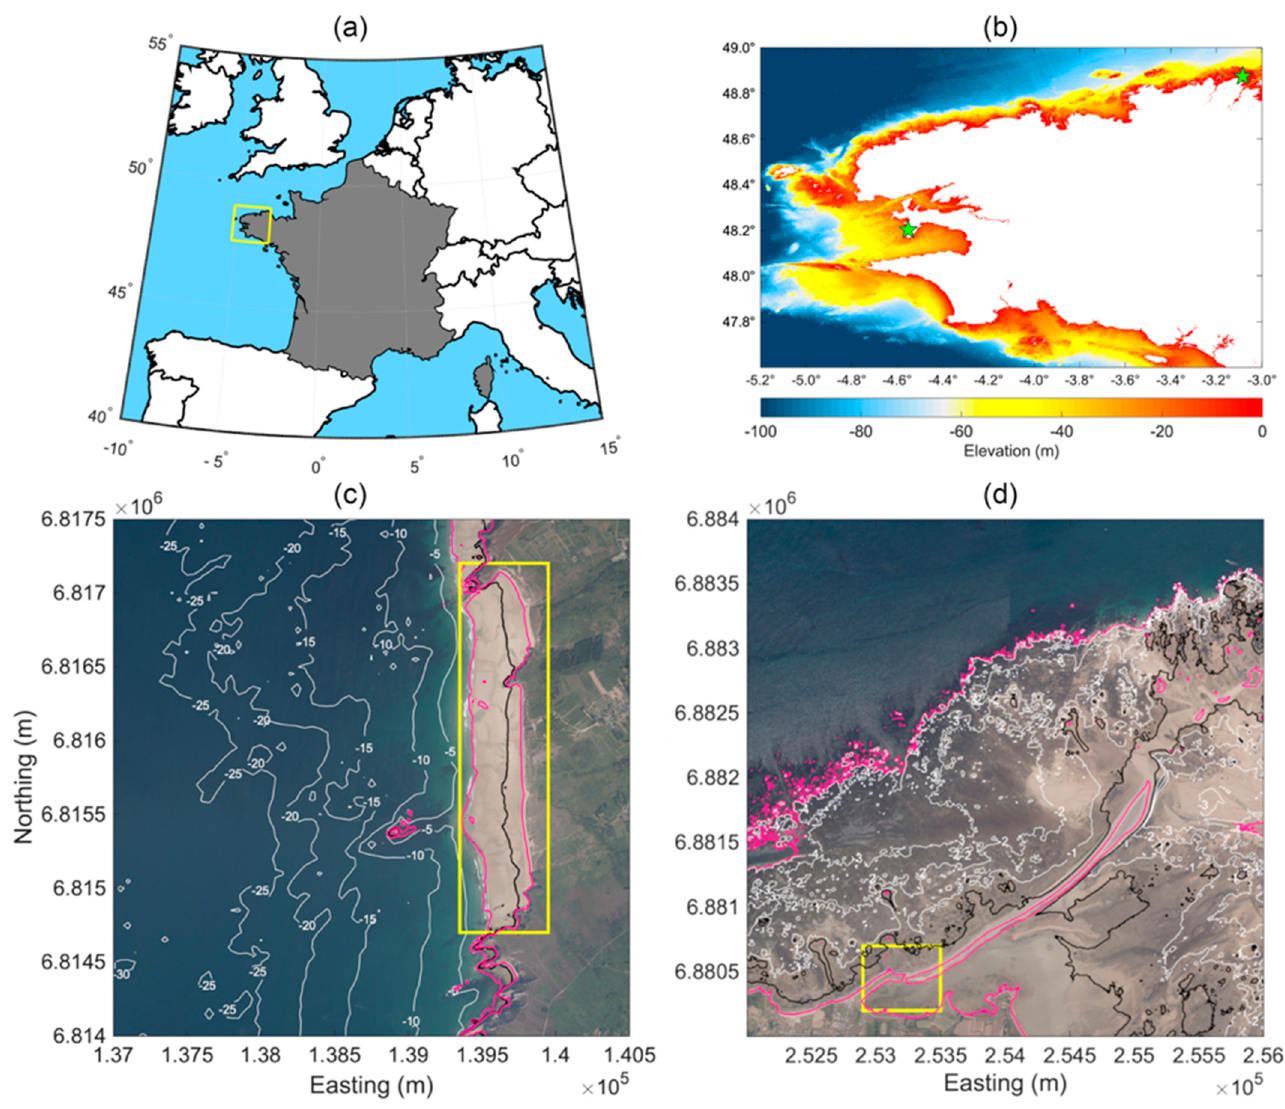
Figure 1. Survey sites. ( a ) Map of France; ( b ) bathymetric DEM of western Brittany with green stars representing field sites at La Palue (left) and Sillon de Talbert (top right); ( c , d ) orthophotographs (source: Ortho Littorale V2, Ministère en charge de l’environnement, 2013) of La Palue and Sillon de Talbert, respectively, showing the (yellow enclosed) survey area and depth contours (source: Litto3D Finistère 2014—Shom). Black and pink lines represent MSL and MLWS/MHWS, respectively.